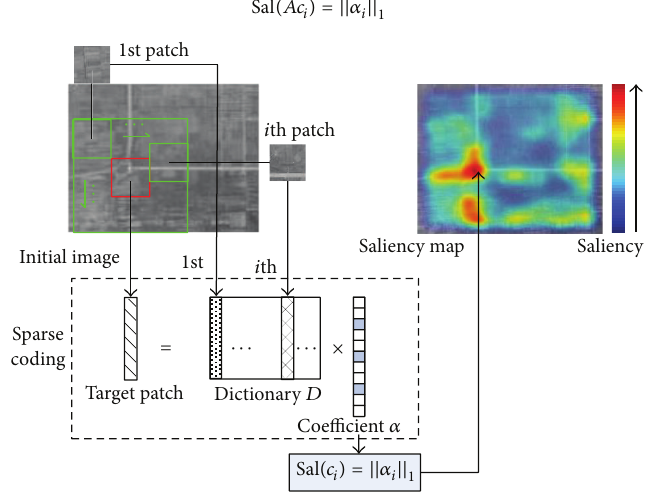
Figure 3: Local saliency based on sparse